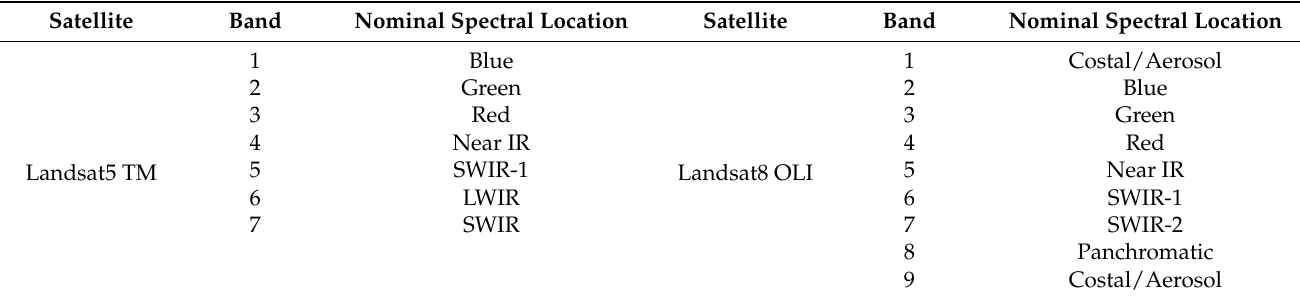
Table 1. Landsat5 TM/8 OLI data